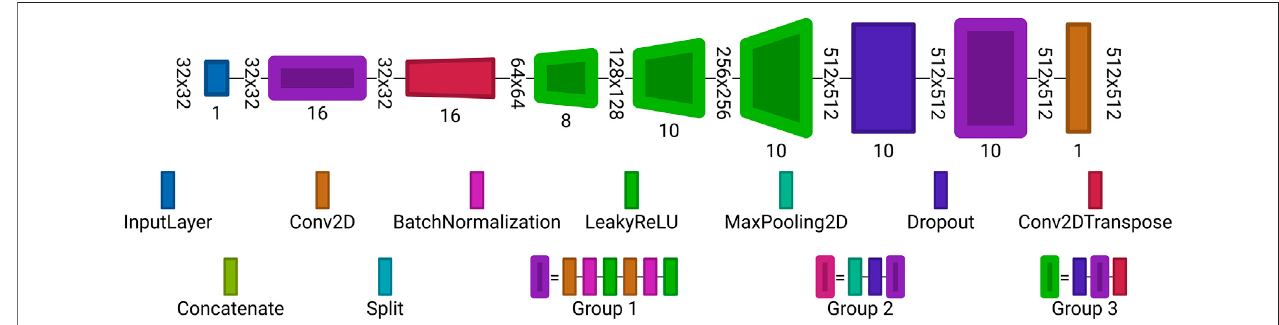
FIGURE 7 | Autoencoder architecture used for reconstruction from undersampled observations. Each block is a set of layers. The layer labeling is the same as in Figure 6 . Visualized with Net2Vis [55].